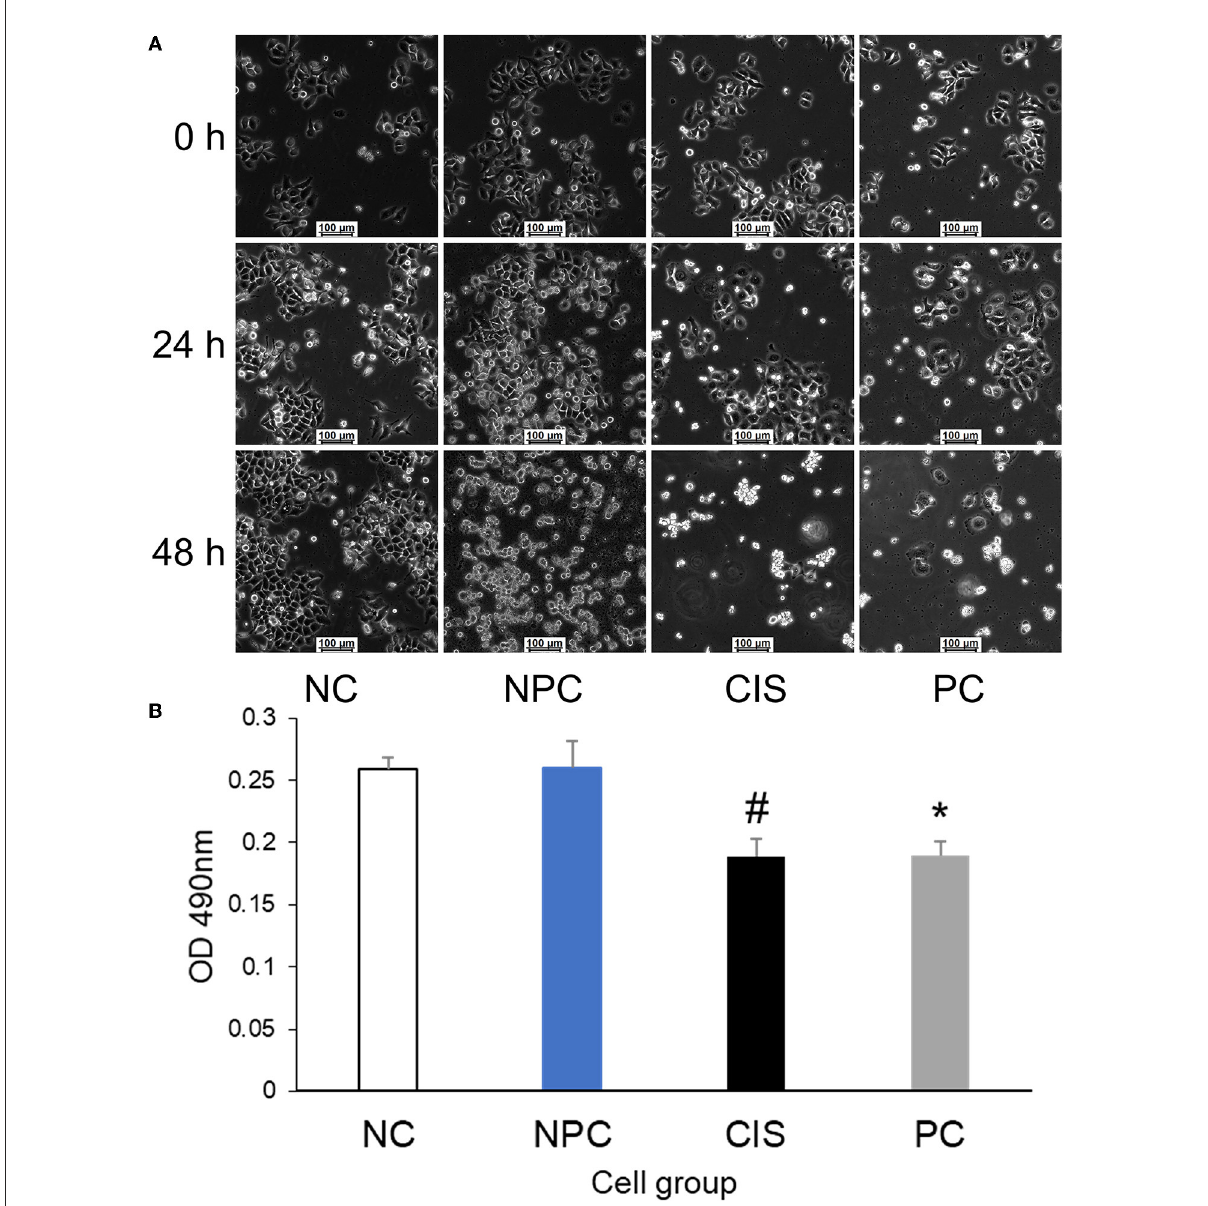
FIGURE2 Effects of C-phycocyanin on the viability of HepG2 cells. (A) Cell morphology of HepG2 cells at the same site for 48h; (B) MTT test of HepG2 cells. The CIS group compared with the NC and NPC groups (# p < 0.01); the PC group compared with the NC and NPC groups (* p < 0.05). NC, normal control; NPC, normal control with C-phycocyanin; CIS, cisplatin; PC, cisplatin with C-phycocyanin.